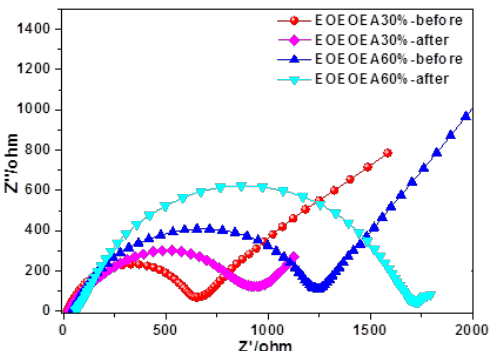
Figure 9. AC impedance plots of LiBF 4 -EOEOEA 30% and LiBF 4 -EOEOEA 60% gel lithium batteries before and after 50 cycles.